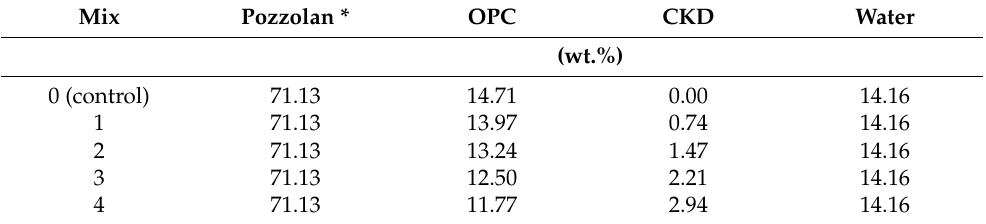
Table 5. Composition of mixtures used in this study (i.e., replacement levels from Table 4 × 14.71). Mix Pozzolan *